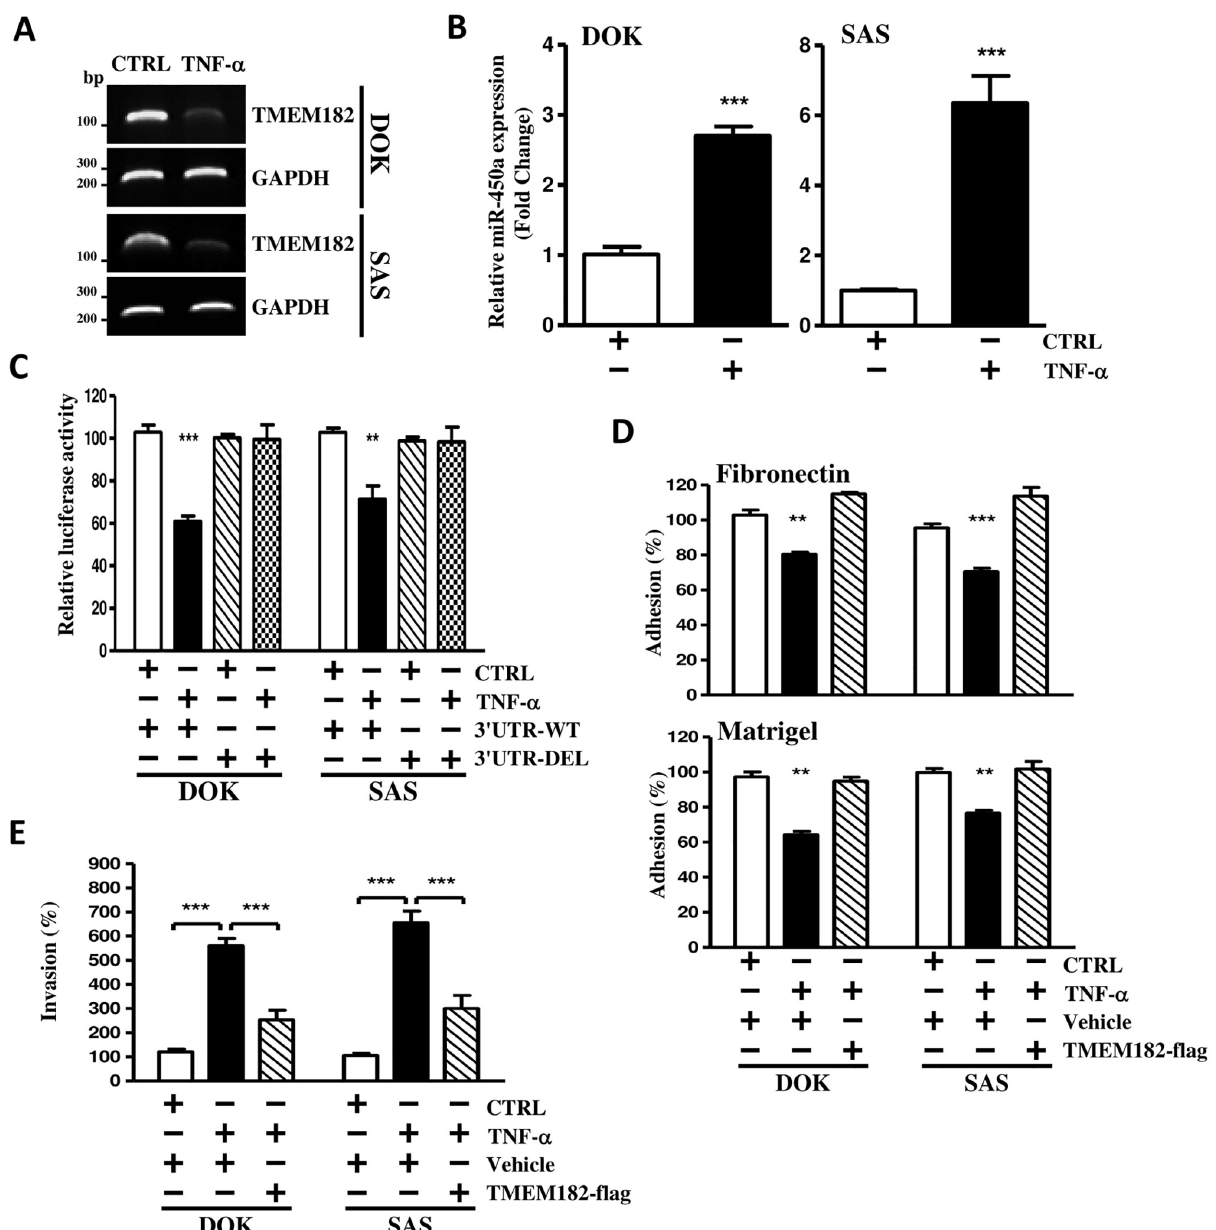
Fig 5. TMEM182 is down-regulated by miR-450a in response to TNF- α in OSCC cells. (A) Levels of TMEM182 in DOK and SAS cells treated with either ddH 2 O (CTRL) or TNF- α were assessed with RT-PCR. GAPDH was used as a control. (B) miR-450a changes in DOK and SAS cells treated with or without TNF- α were measured with qPCR and normalized to RNU44. (C) Luciferase activity measured that TNF- α regulated TMEM182 through miR-450a binding site at 3’-UTR. Cells were transfected with TMEM182 3’-UTRs constructed either with wild-type (3’-UTR-WT) or miR-450a binding site truncated (3’-UTR-DEL), before TNF- α was added for 24 hrs as described in panel. Relative luciferase activities were the ratios of Renilla luciferase normalized to the wild-type control. (D-E) Cells were transfected with either empty vector pCDH-CMV-GFP puro+ (Vehicle) or TMEM182 (TMEM182-flag) followed by the stimulation with TNF- α for 24 hrs, and then, corresponding adhesion ability and invasion ability were measured. Data are represented as mean ± SEM; �� P < 0.01; ��� P < 0.001.